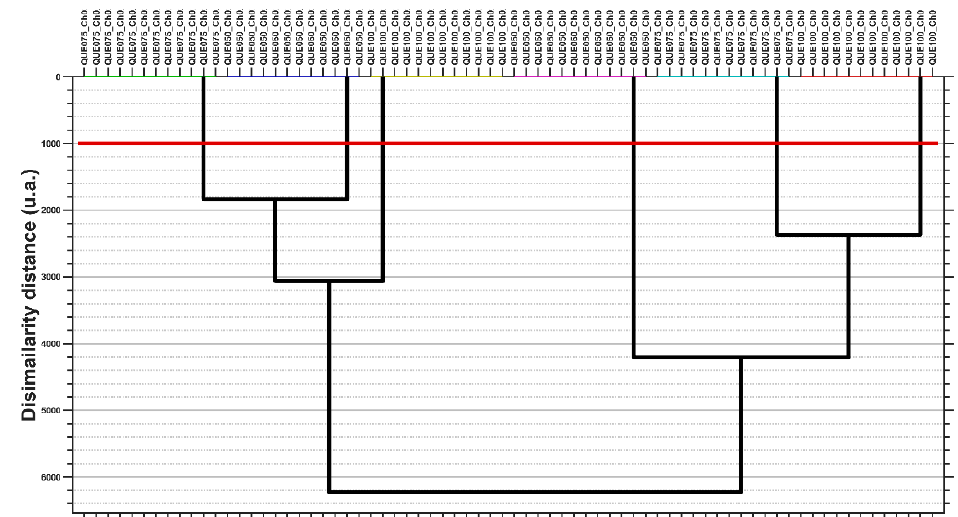
Figure 19. Cluster analysis of MANOVA ( p = 0.05) results: dendrogram representation for principal coordinates of PC1 ÷ PC11 with the cut-off red line used to generate the clusters. Different colors for groupsing of horizontal lines denote sample clusters.